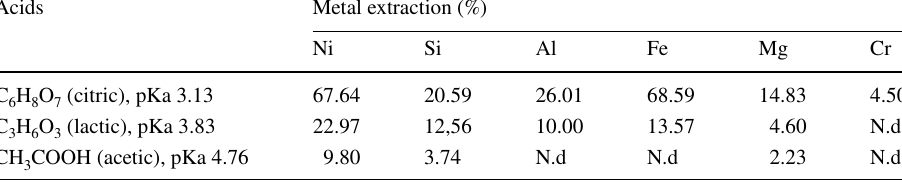
Table 5 Chemical leaching of Ni-laterite (0.25%, w/v) under different acidic solutions (50%, v/v) during 7